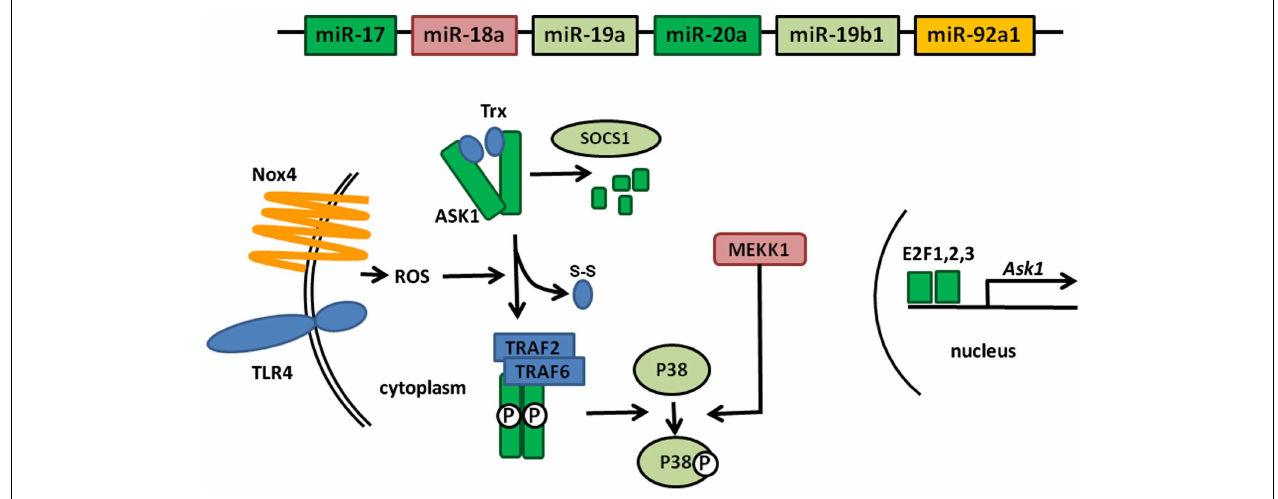
ASK1 signalosome that they are predicted to target. Proteins shown in blue (TLR4,Trx,TRAF2, andTRAF6) do not contain miRNA-binding sites for members of the cluster miR-17 ∼ 92 in their 3 (cid:48)